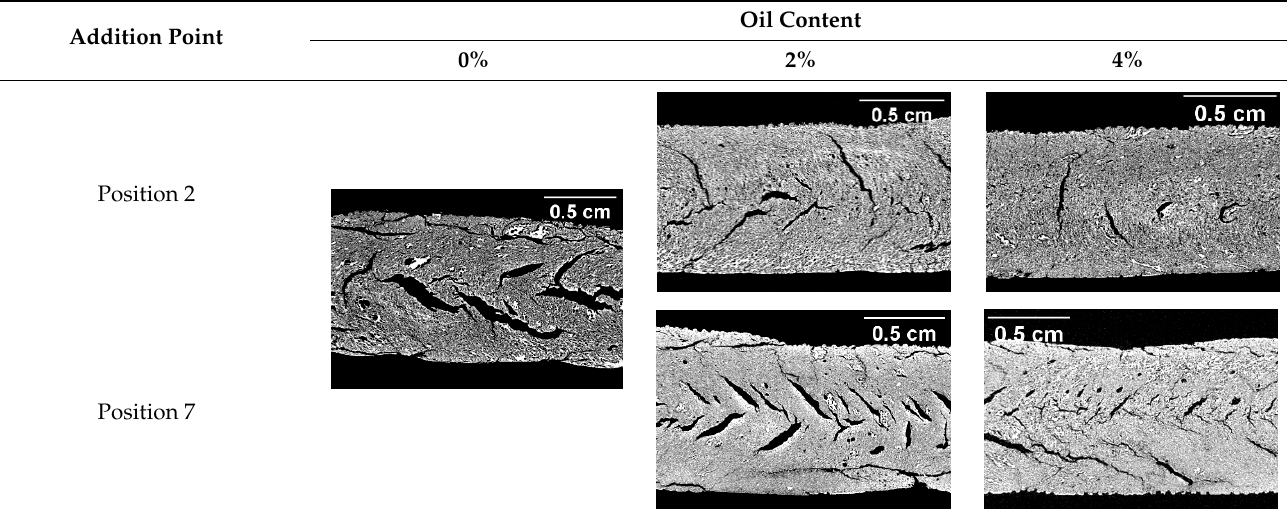
Table 2. Micro-computed tomograph (micro-CT) images of freeze-dried extrudate samples. Influence of oil content on the anisotropic structure as a function of the oil addition point (position 2 and 7). The barrel temperature was 120 °C, screw speed was 400 rpm, total mass flow was 10 kg/h and water content was 51–53% for all samples.